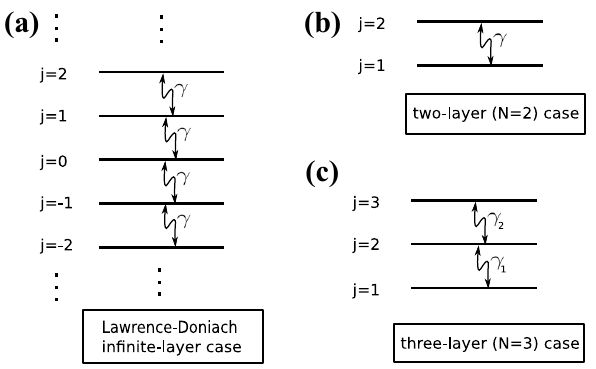
Fig. 1 Panel a Schematic representation of a Lawrence–Doniach (LD) or infinite-layer ( N → ∞ ) superconductor, with single inter- layer distances and Josephson couplings between adjacent layers. Panel b Schematic representation of a two-layer superconductor ( N = 2 , see Sects. 2.2 and 4). Panel c Schematic representation of a three-layer superconductor ( N = 3 ; see Sect. 2.3, and also Sect. 5 for the 𝛾 1 = 𝛾 2 case or Sect. 6 for 𝛾 1 > 𝛾 2 ). In ( b , c ), each layer j may have a different T cj or a common one; our discussions in Sect.s 4–6 focus in the latter case